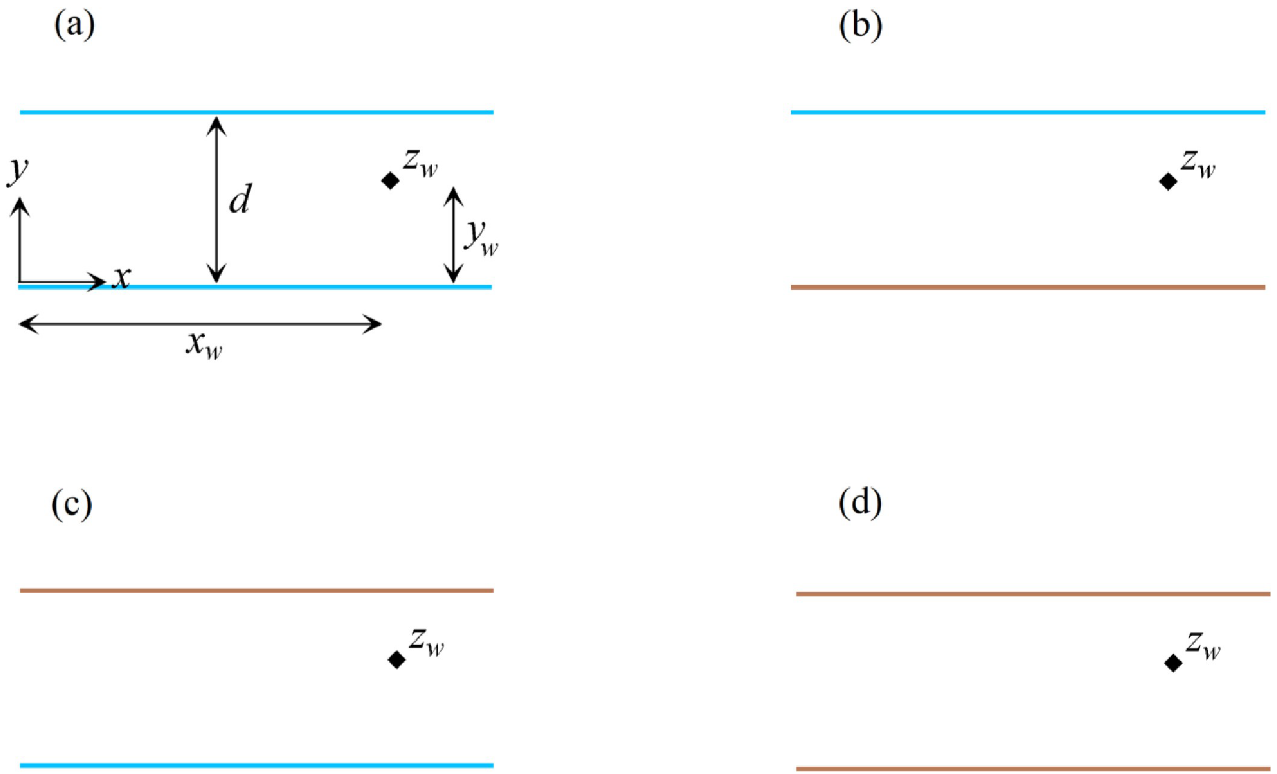
Fig 1. Schematic plan view of a strip-shaped aquifer with various boundary configurations: a) inflow-inflow, b) inflow-barrier, c) barrier-inflow and d) barrier-barrier. In this figure, blue and brown lines show inflow and barrier boundaries, respectively. Black diamonds represent wells.